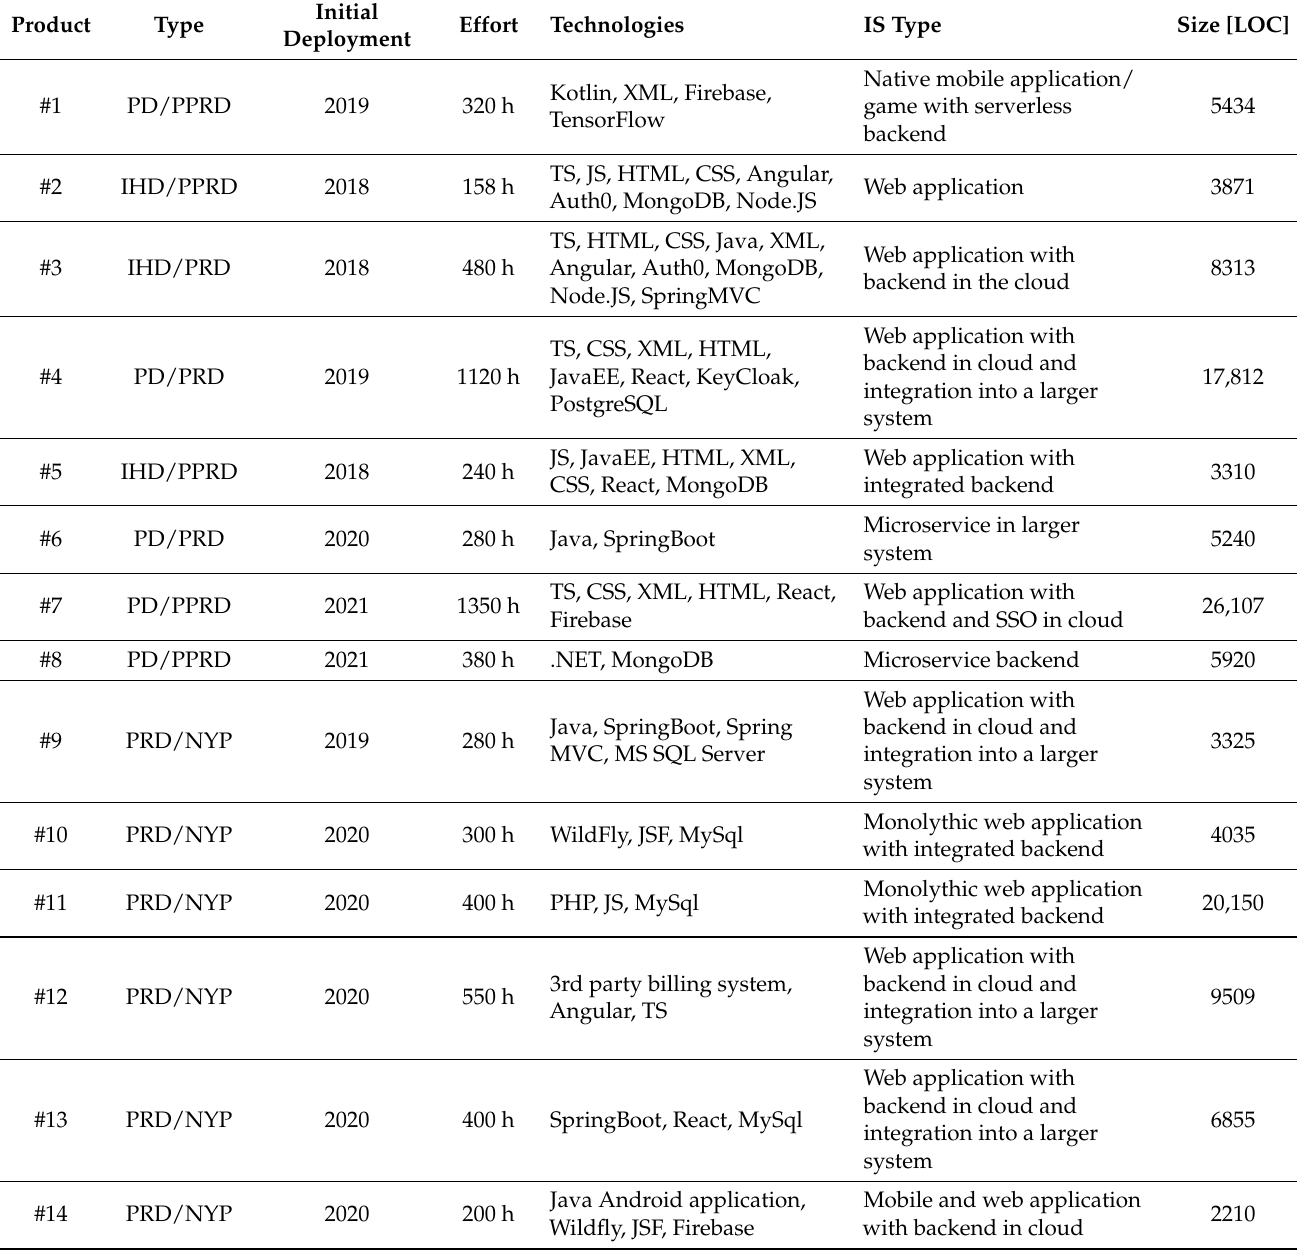
Table 2. The projects under